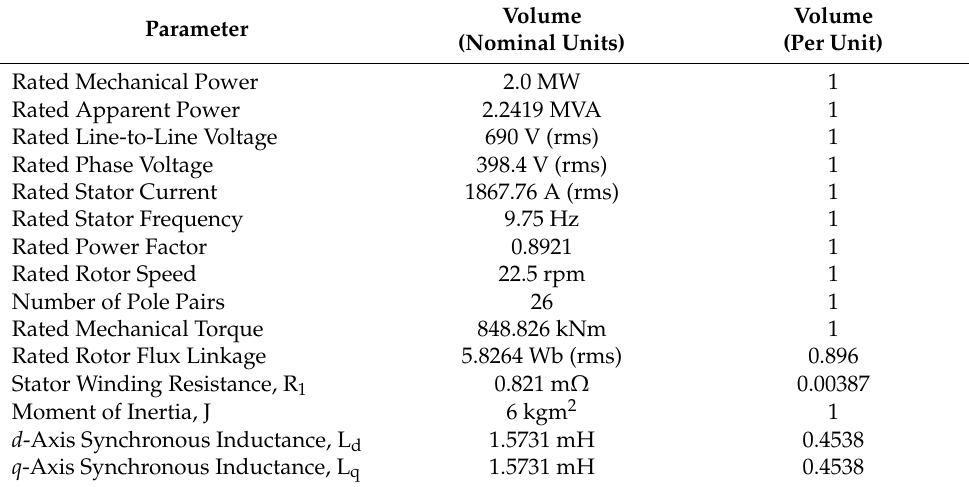
Table 1. Data of an exemplary PMSM used in the ship’s propulsion. Parameter